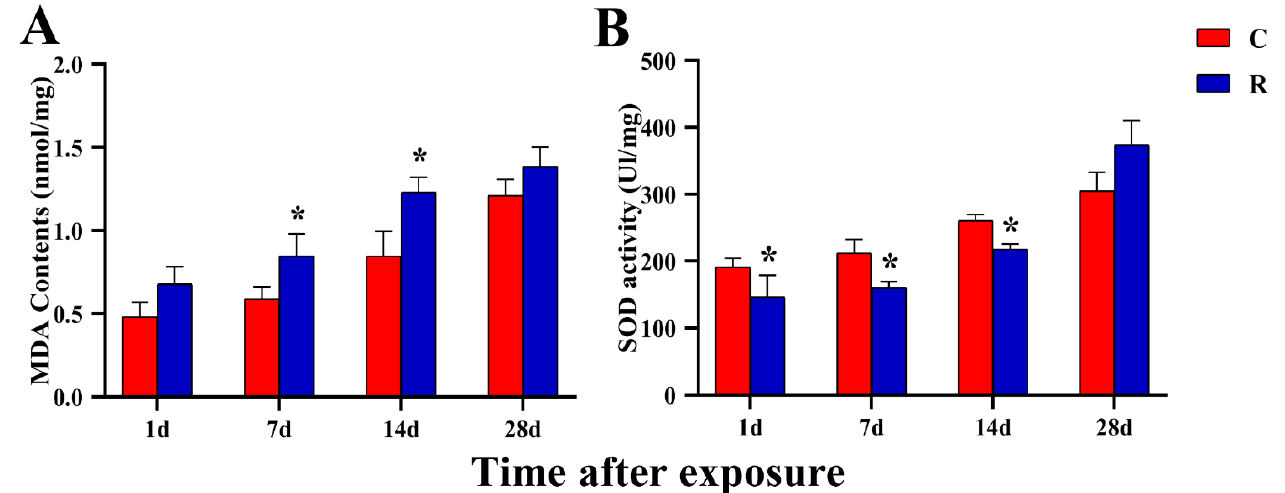
Figure 5. Changes in levels of rats’ myocardial oxidative stress after S-band radiation. ( A ) MDA content; ( B ) SOD activity. Significance signs were classified according to p -value: * p < 0.05.